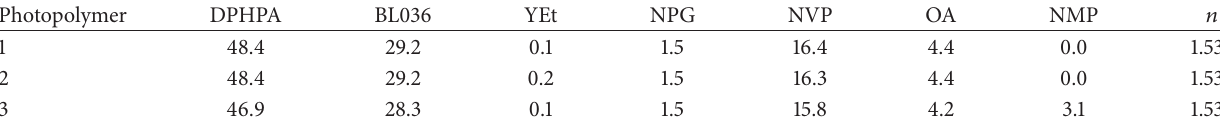
Table 1: Composition of photopolymers 1, 2, and 3 in wt% and the refractive index of the final mixture.